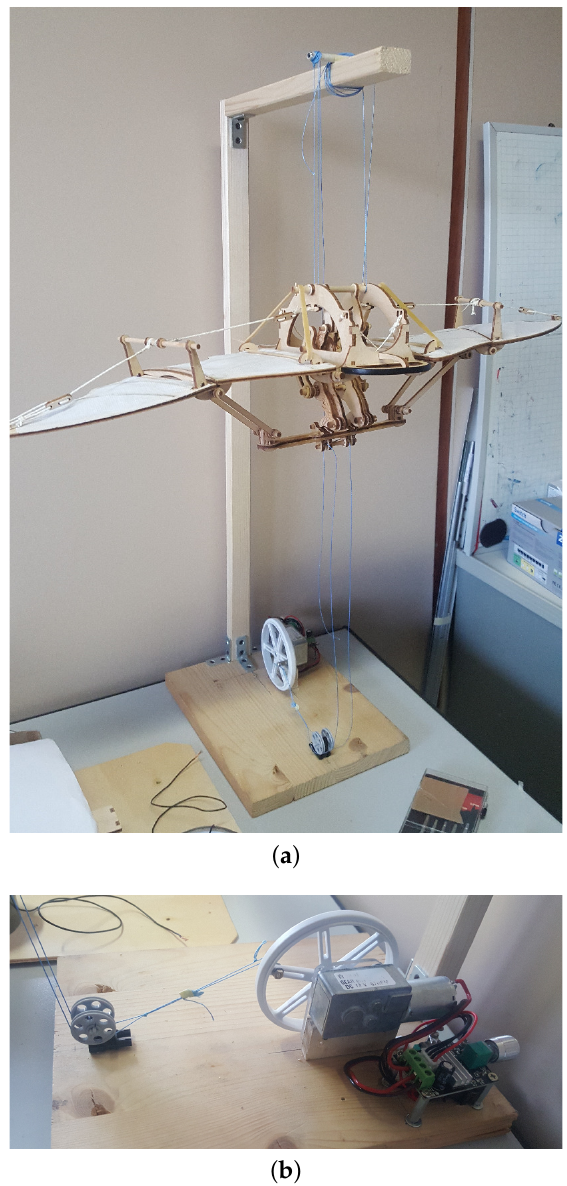
Figure 9. Leonardo flying machine automated setup: ( a ) complete setup; ( b ) detail of the actuation